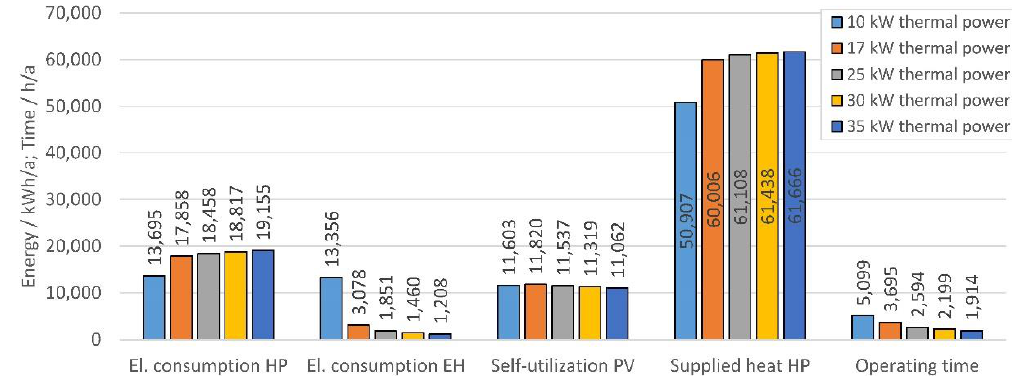
Figure 6. Electricity consumption of heat pump and electric heater, self-utilization of PV electricity, supplied heat by the heat pump and yearly operating hours for different BWHP systems in MFH category 1 reference building for year 2020.